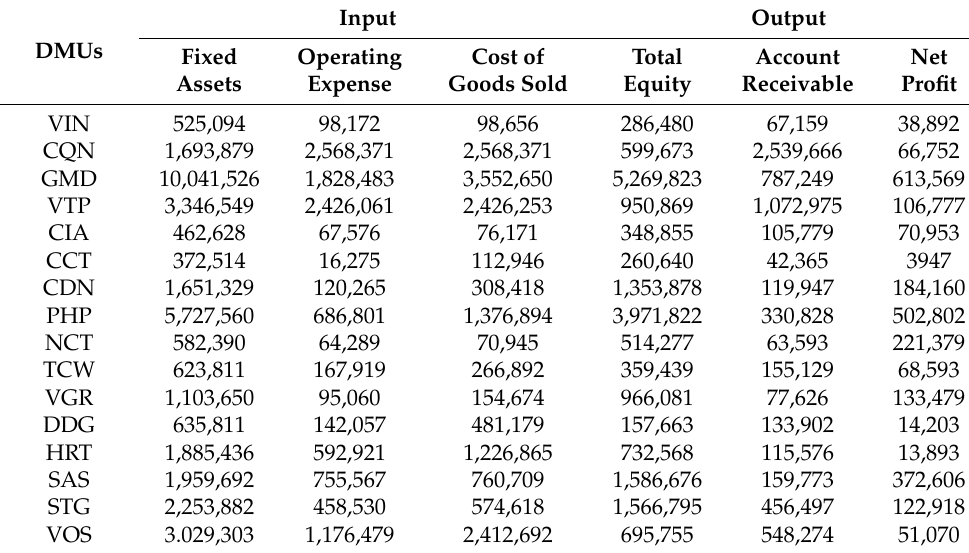
Table 5. The data of Vietnam logistics company 2021 (Unit: million